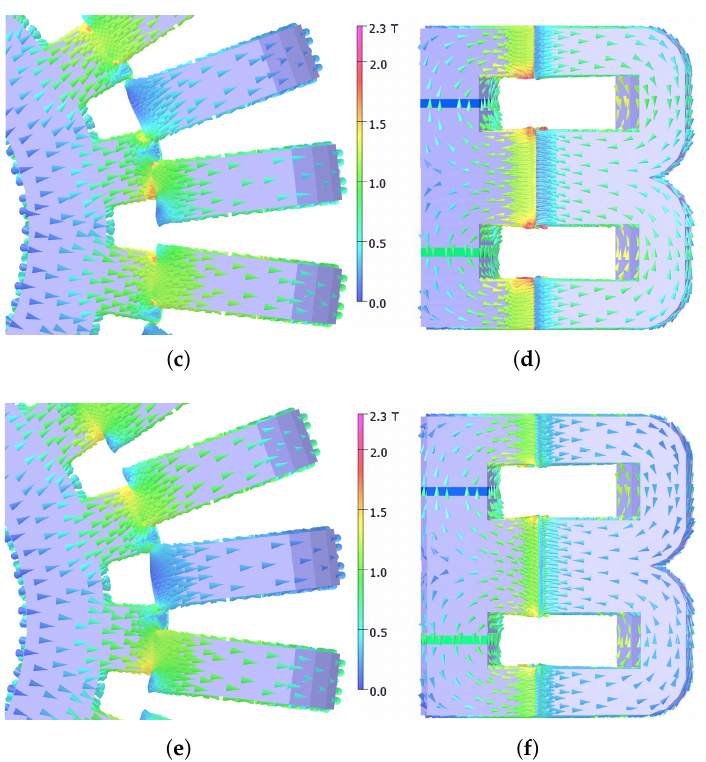
Figure 4. HM3D machine principle, magnetic flux density vector; ( a ) yz -plane, aligned, ( b ) xy -plane aligned, ( c ) yz -plane, intermediate, ( d ) xy -plane, intermediate, ( e ) yz -plane, un-aligned, and ( f ) xy -plane un-aligned.